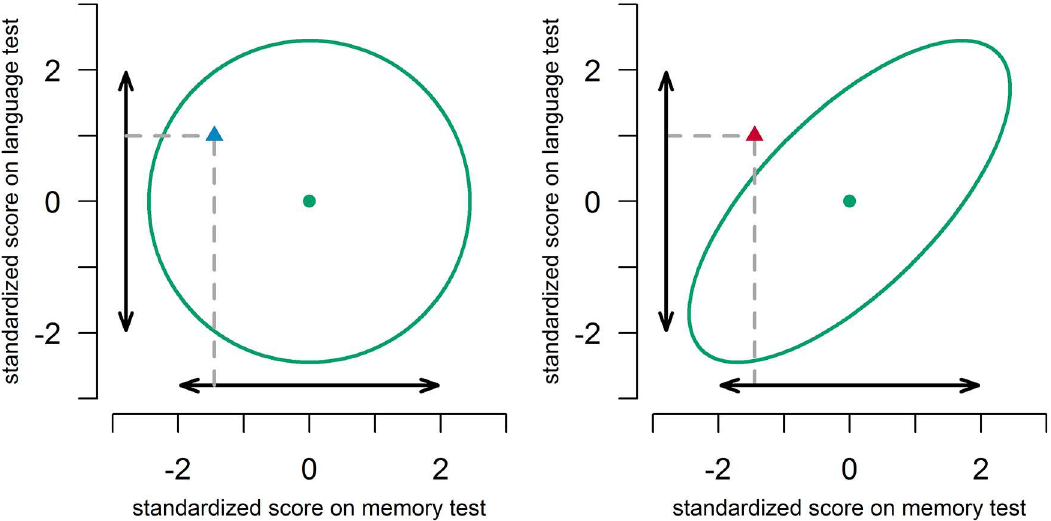
Fig 1. Illustration of multivariate normative comparisons in a situation with scores on two neuropsychological tests. The double-headed arrows denote the 95% univariateintervals. The ellipsesdenote the 95% multivariate region. The dots denote the mean score in the norm group. The trianglesdepict a patient’s scores. In the left panel, tests are uncorrelated(r = 0.0). In the right panel, tests are correlated(r = 0.7).